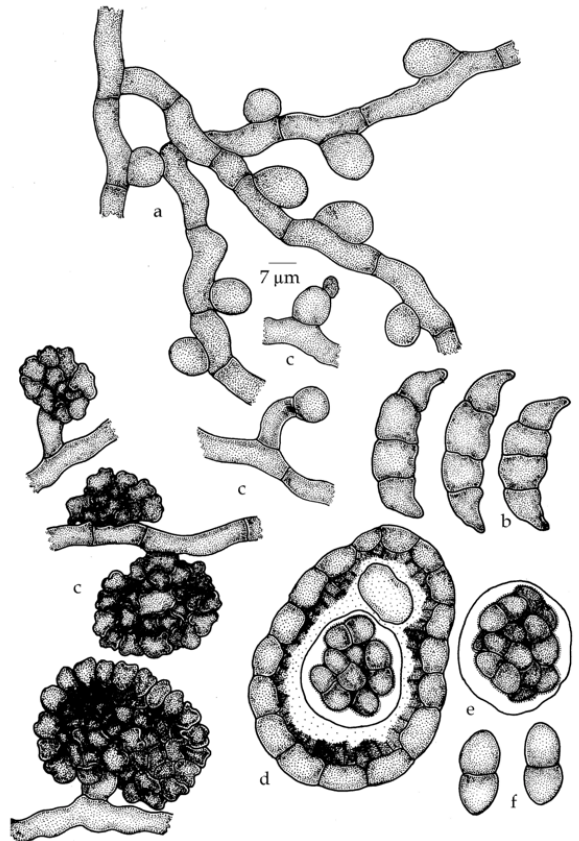
Figure 195. Schiffnerula spilanthi a - Appressoriate mycelium; b - Conidia of Questieriella ; c - Thyriothecium initials; d - Thyriothecium; e - Ascus; f - Ascospores